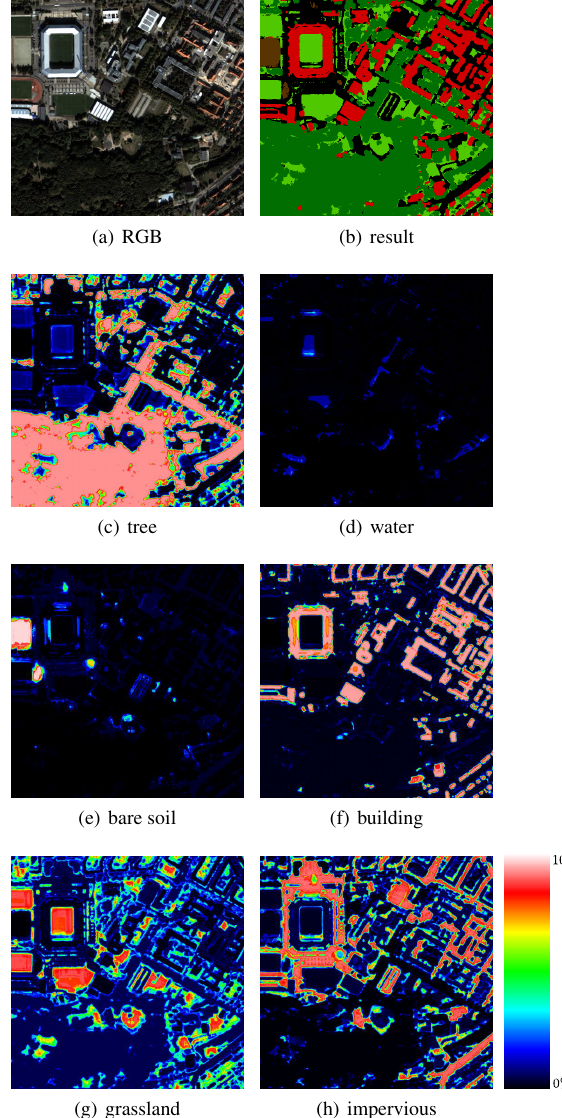
Figure 8: Probability maps for all classes (each sample area is 840 × 840m